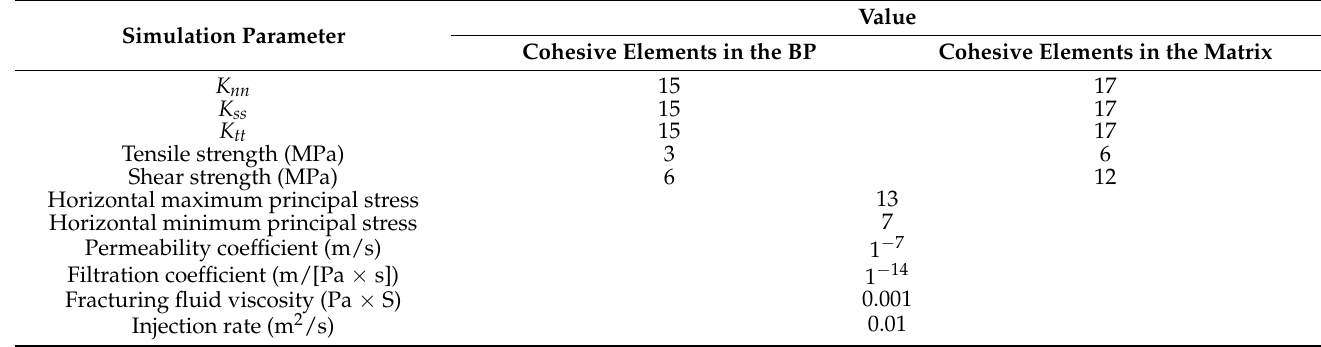
Table 2. Basic reservoir and cohesive element